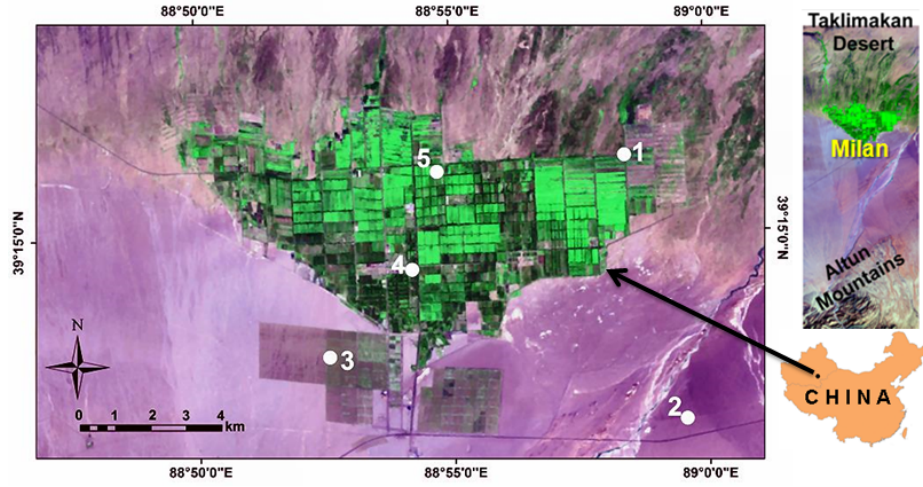
Figure 1. Satellite map (Landsat ETM + ; 2011) of Milan oasis, Xinjiang, NW China (The map has an area of 338km 2 ) . The white circles show the sites of in situ measurements: natural forest (1), desert (2), jujube (3), hotel/oasis station (4) and cotton field